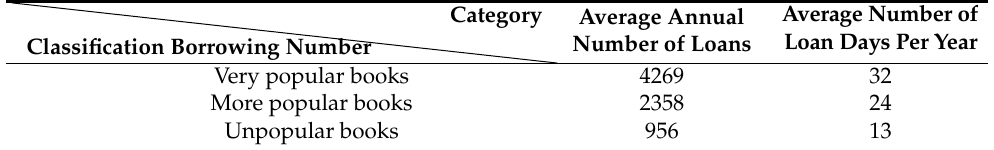
Table 1. Library classification clustering